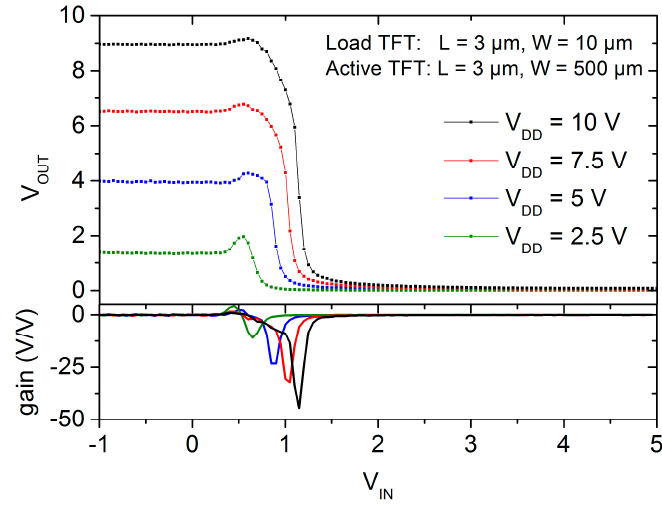
Figure 7. Voltage transfer characteristic of a ZnO nanoparticle inverter with different supply voltages. The bottom graph depicts the gain in dependence on the input voltage.